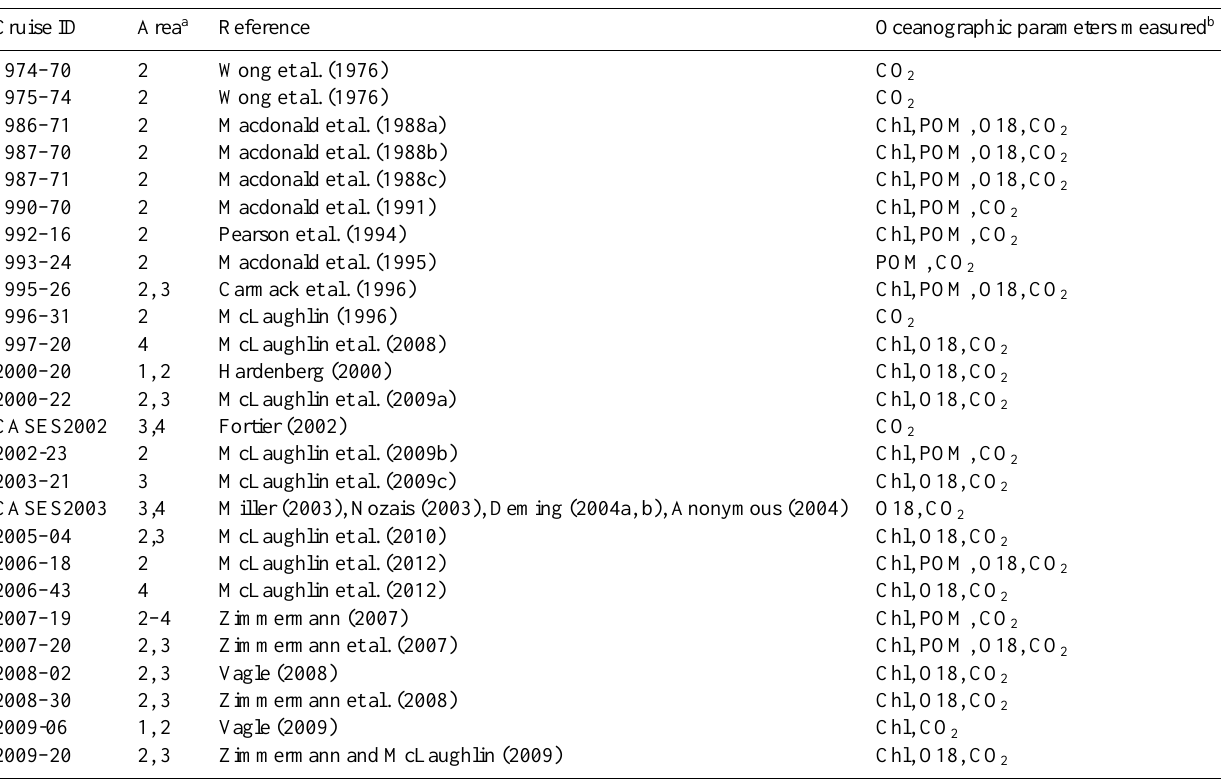
Table 1. List of the cruises included in the time-series data set and the associated information, including dates, references (cruise and data reports), and measured parameters.